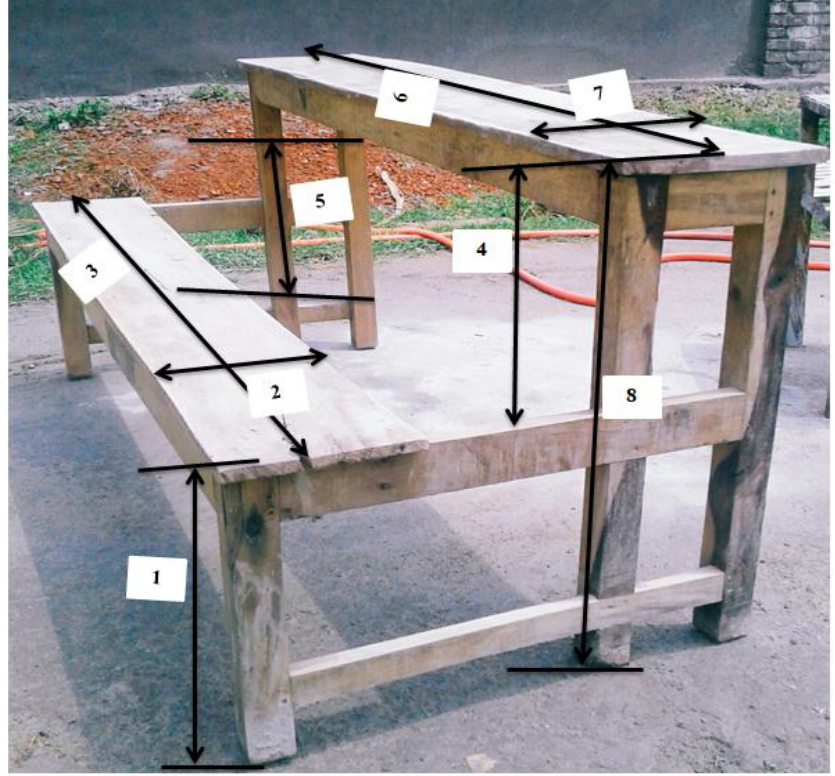
Figure 2. Existing classroom furniture